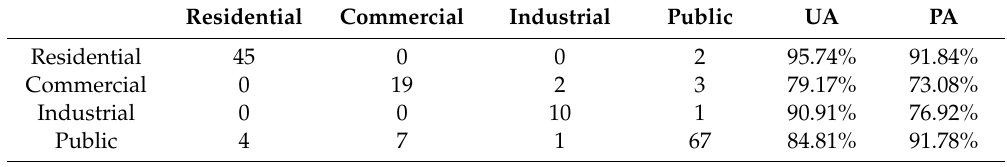
Table 3. Confusion matrix for the Level I category of EULUC-seg. Due to the limited testing samples of transportation lands, we exclude this kind of category here in the accuracy assessment. UA, PA, and OA denote user’s accuracy, producer’s accuracy, and overall accuracy, respectively.